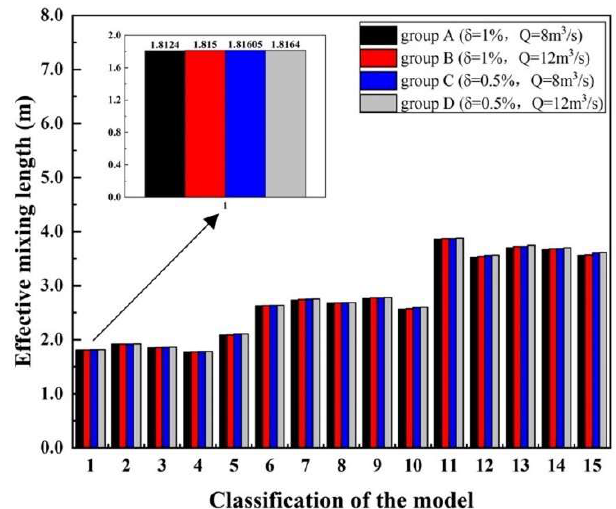
Figure 9. Variation tendency of L EML under di ff erent cross-flow fluxes and mixing ratios.